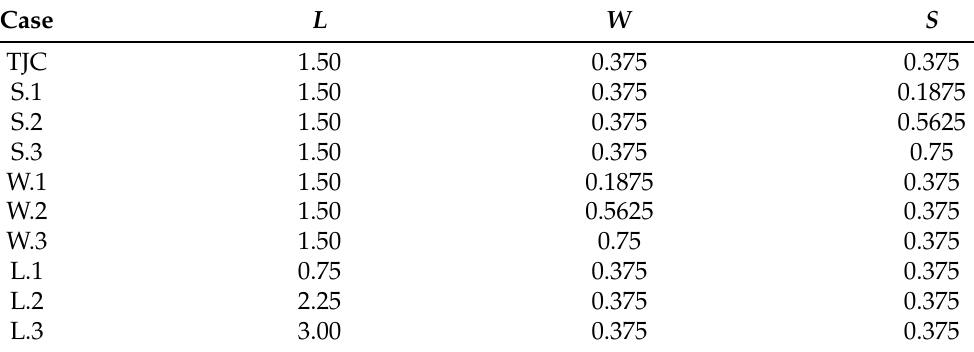
Table 1. Geometrical dimension of the cavities used in the